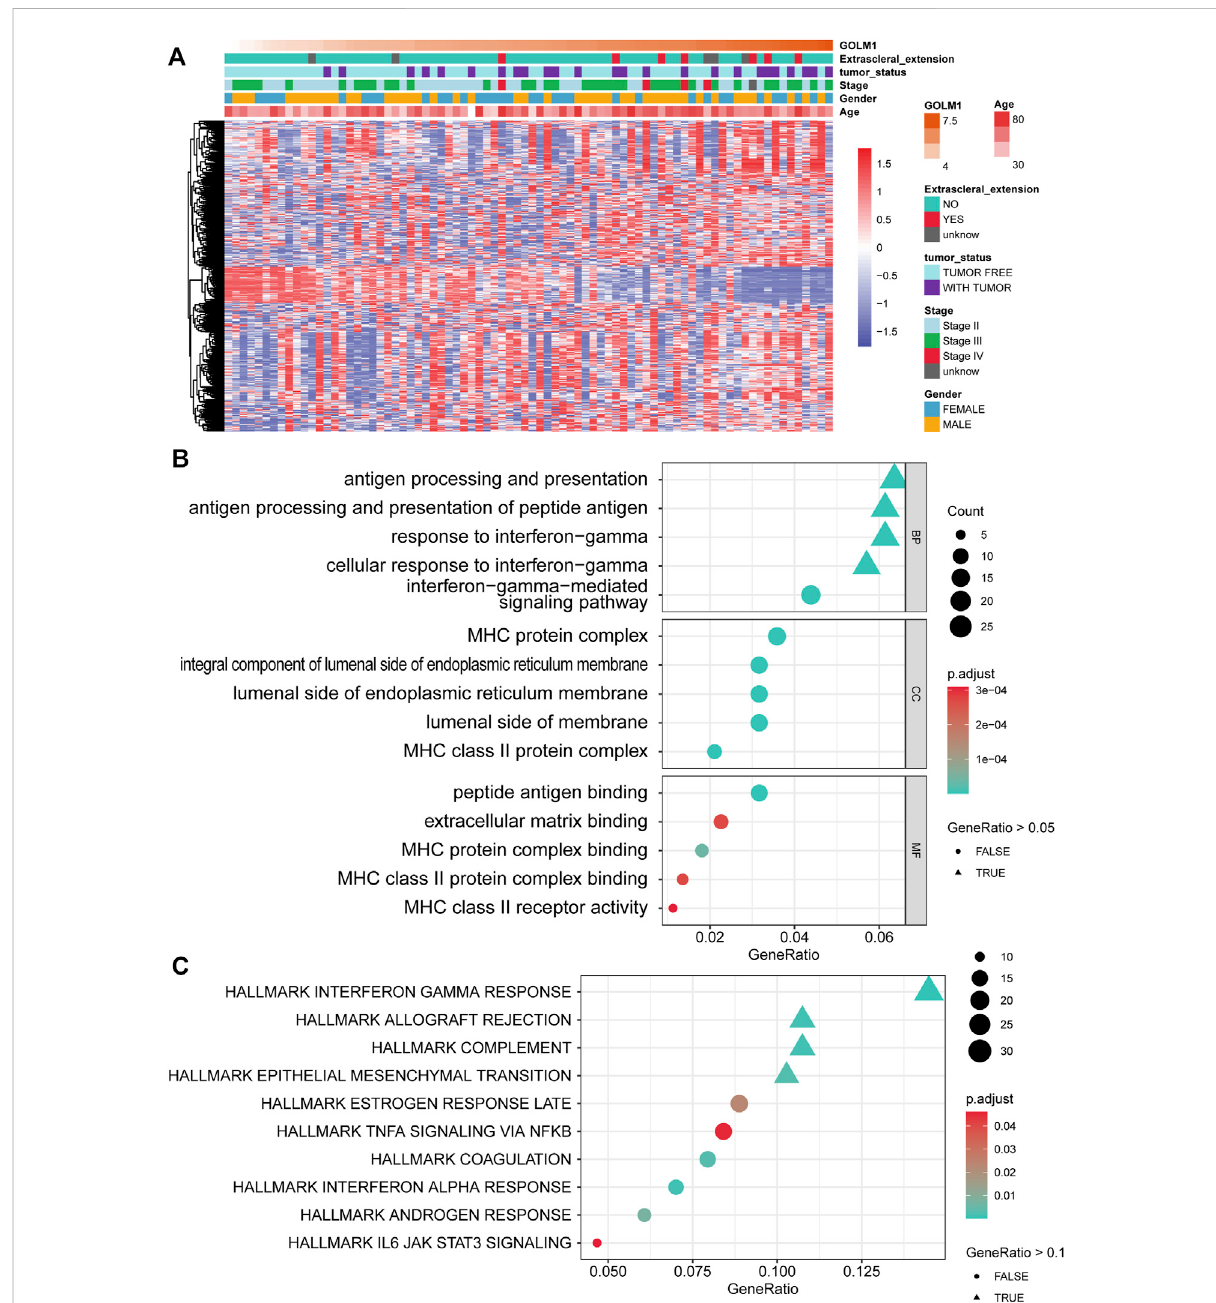
FIGURE 3 Pathway enrichment of GOLM1-associated genes. (A) Heatmap showing the expression of 531 differentially expressed genes (DEGs) between the GOLM1-low (LEXP) and GOLM1-high (HEXP) subgroups; (B) Pathway enrichment of the gene ontology (GO) terms for these DEGs; (C) Pathway enrichment of the HALLMARK terms for these